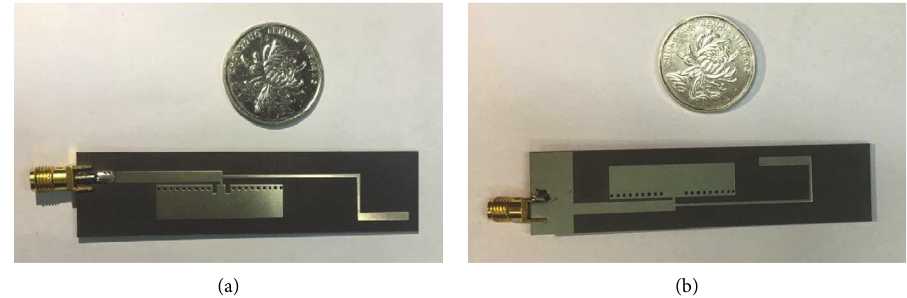
Figure 6: The fabricated antenna: (a) top view; (b) bottom view.